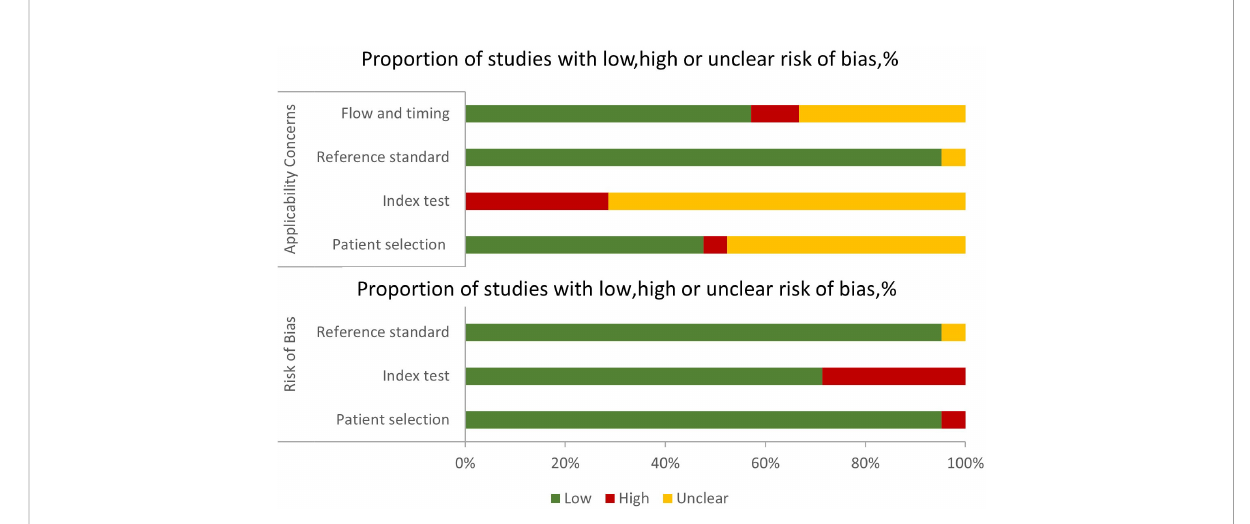
FIGURE 3 Grouped bar charts of the risk of bias and applicability concerns of the included studies were assessed by using a revised tool for the Quality Assessment of Diagnostic Accuracy Studies (QUADAS-2).